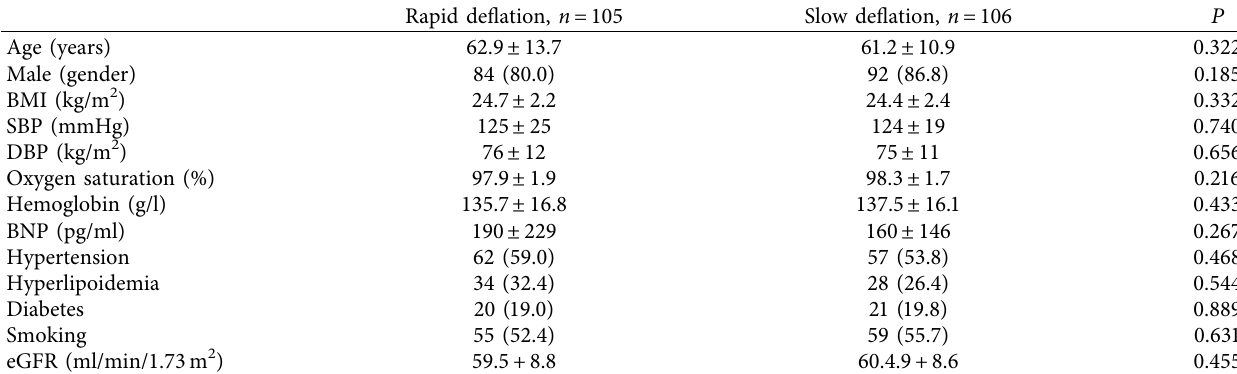
Table 1: Baseline characteristics.